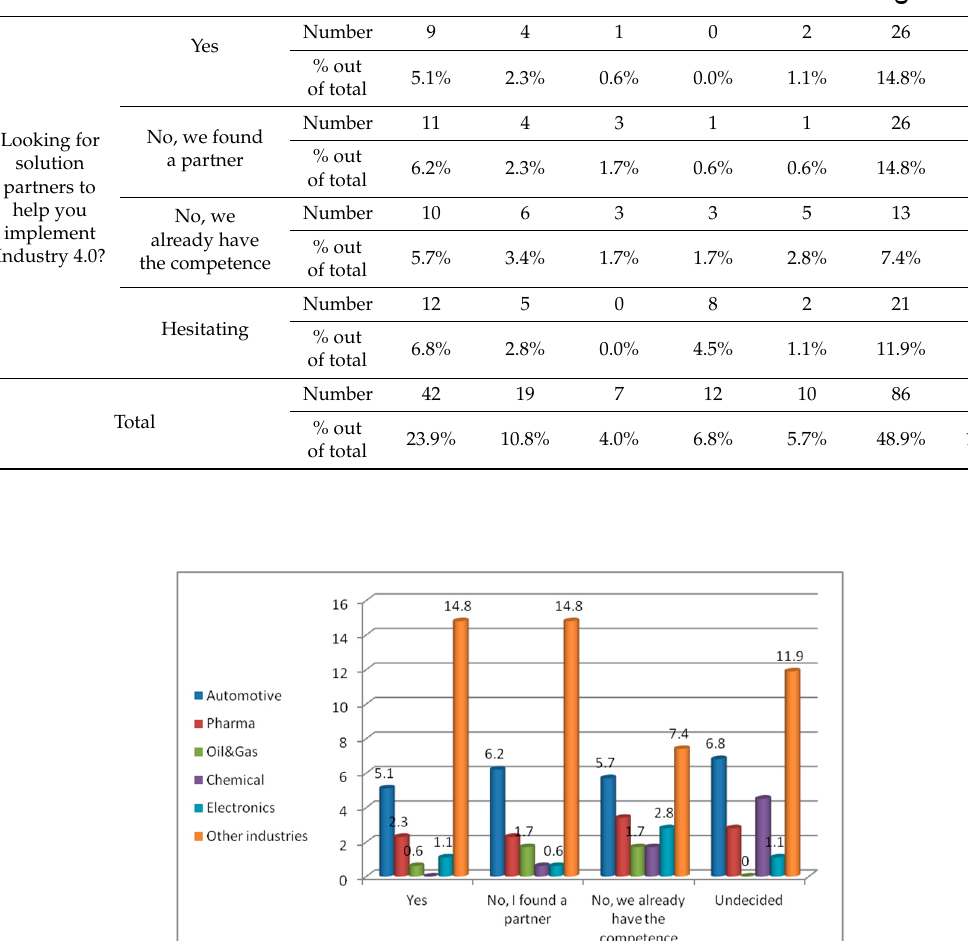
Table 3. Frequency table for multiple response analysis regarding future technology types implemented by Small and Medium-sized Enterprises (SMEs). $V3 Frequencies